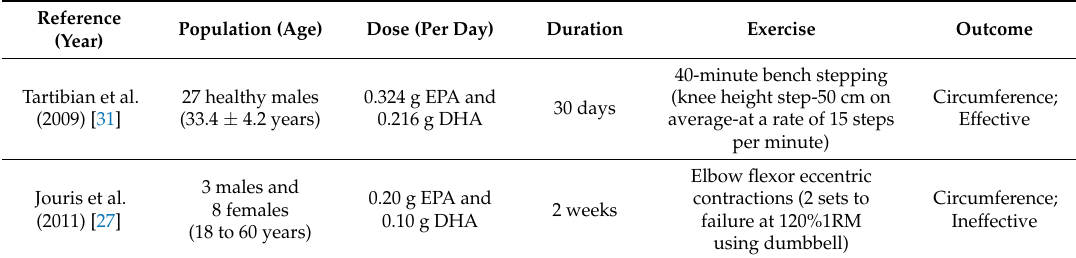
Table 4. Summary of effects of EPA/DHA supplementation on muscle